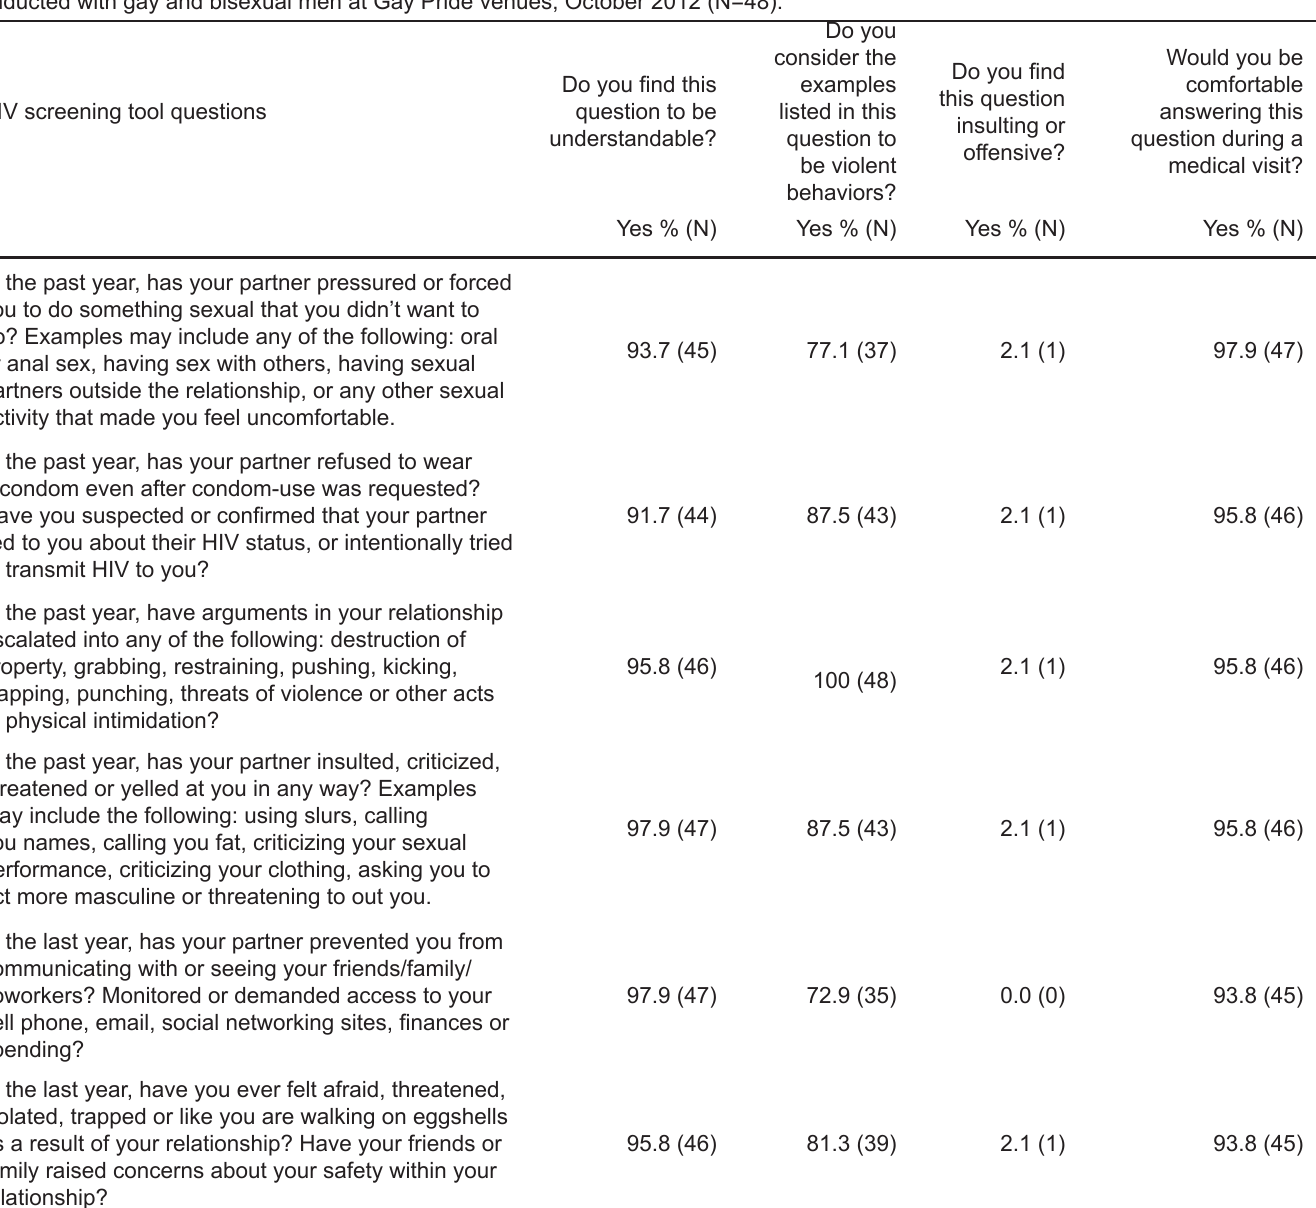
Table 2: Results of cognitive interviewing of human immunodeficiency virus (HIV) screening tool. Data are from individual interviews conducted with gay and bisexual men at Gay Pride venues, October 2012 (N=48).